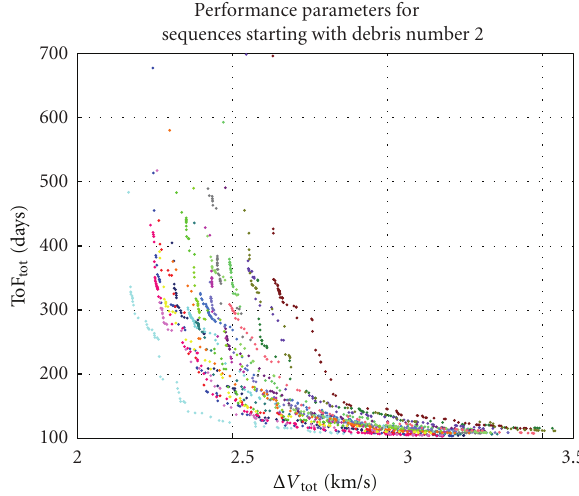
Figure 12: Pareto fronts for sequences starting with debris nr. 2.